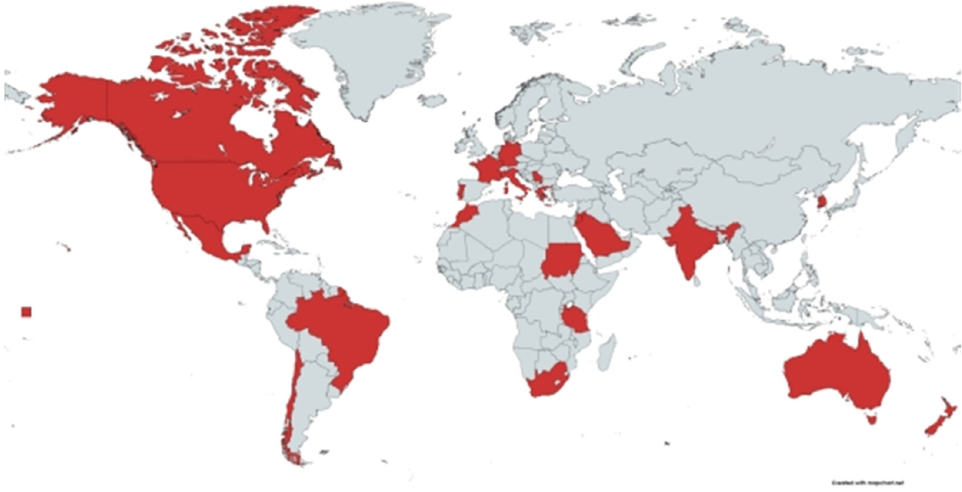
Figure 1. Countries with reported cases of paratuberculosis is small ruminants. The map was cre- ated from https://mapchart.net/world.html. from